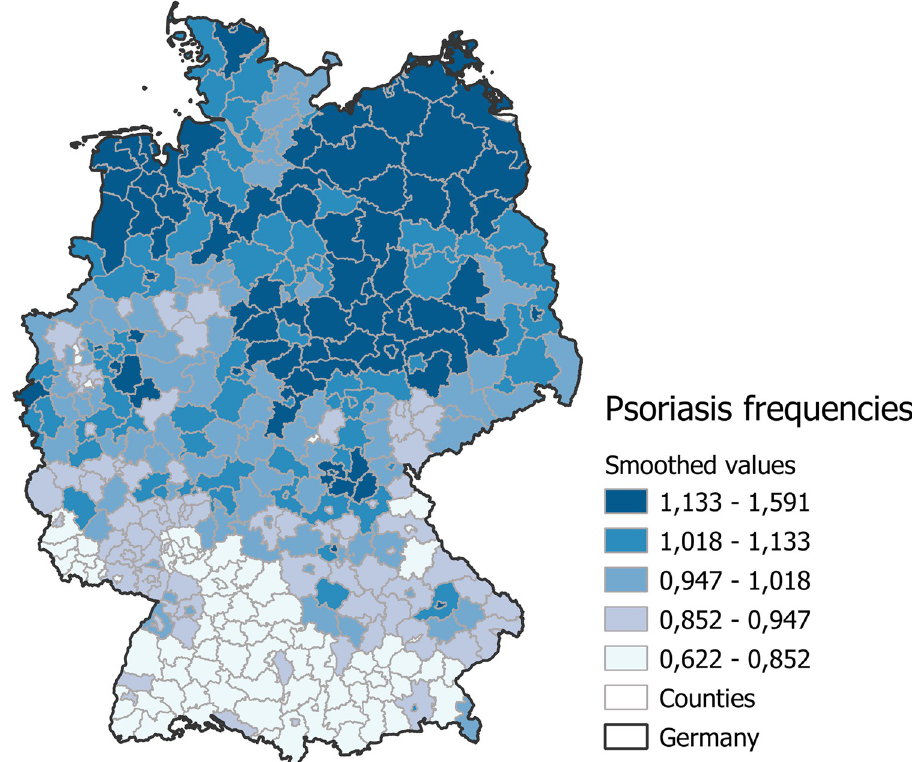
Fig 1. Smoothed regional patterns of the sex- and age-standardised overall psoriasis prevalence (regardless the factor comorbidity) in 2017 at the level of the 402 counties in Germany. Republished from Andrees et al. [36] under a CC BY-NC 4.0